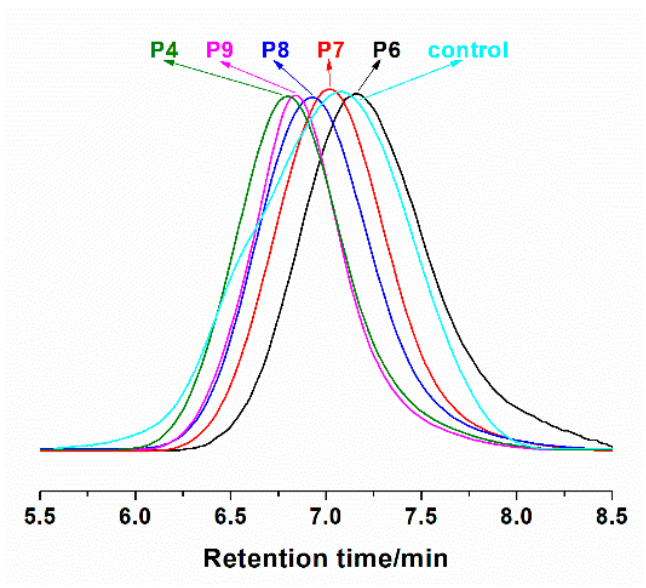
Figure 4. GPC traces of some representative copolymers.